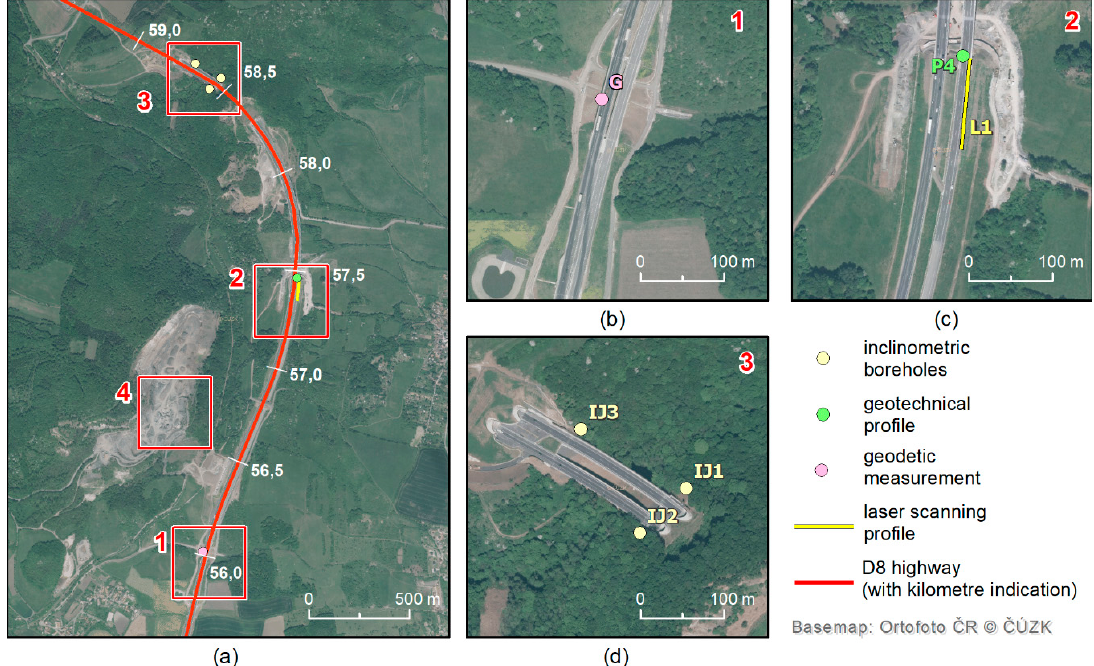
Figure 12. ( a ) Overview of the four sites with detected subsidence: 1: Area of the highway embankment between Je č ky Bridge and Dobkovi č ky Bridge at km 55,700 − 56,000; 2: Prackovice Bridge, 57,300–57,500 km; 3: Area between two highway tunnels (“Prackovice” and “Radej č ín”) at km 58,400; 4: Dobkovi č ky quarry. ( b – d ) Localization of in situ measurements in polygons 1–3: inclinometers (IJ1-3), laser scanning (L1), and geodetic measurements (G, P4).